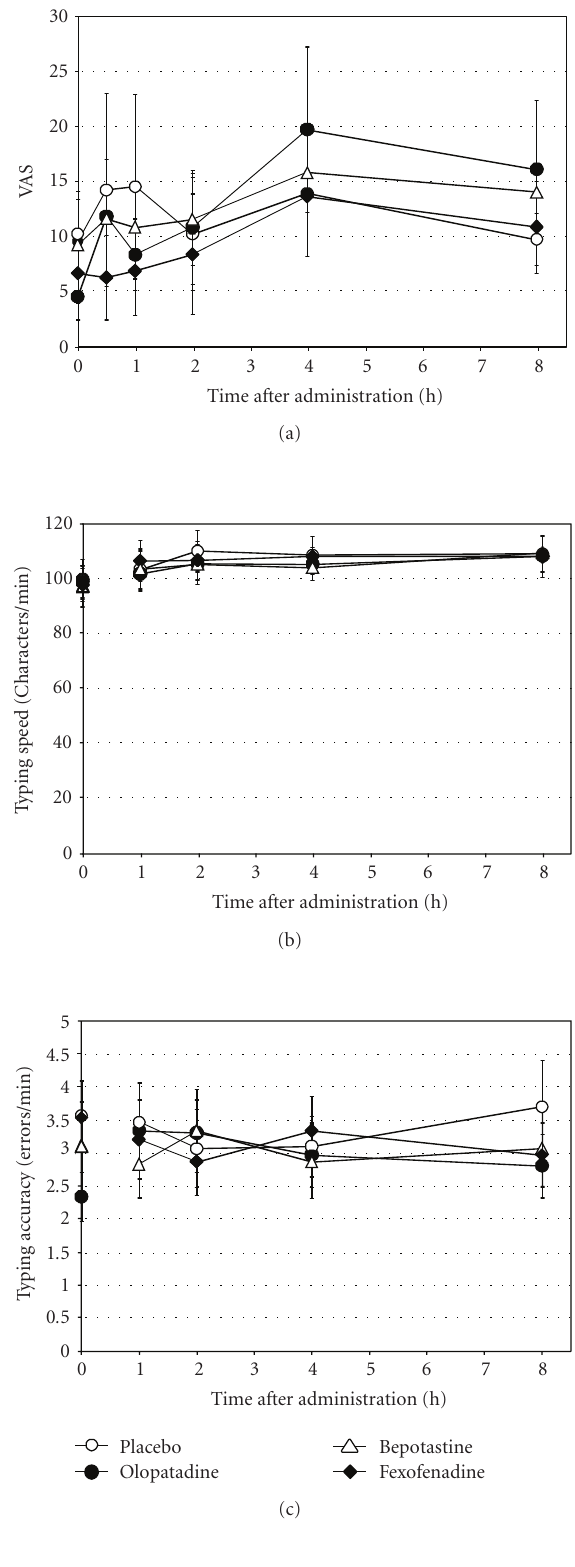
Figure 3: Evaluation of sedative e ff ects by VAS score for sleepiness (a), typing speed (b), and typing accuracy (c) ( n = 10). (a) VAS scores: 0 (no drowsiness) to 100 (extensive drowsiness). Resutls are presented as mean ±